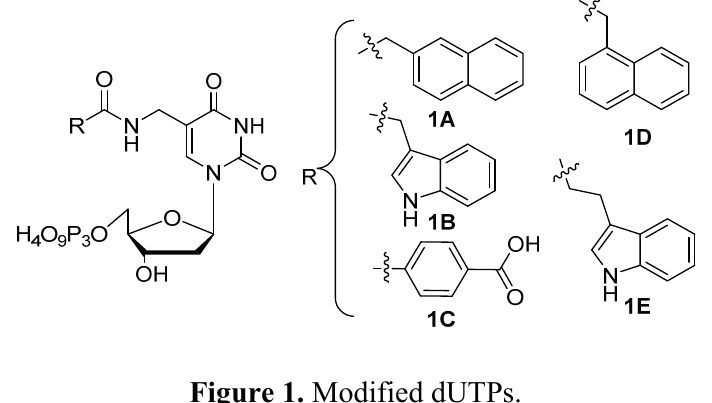
Figure 1. Modified dUTPs.